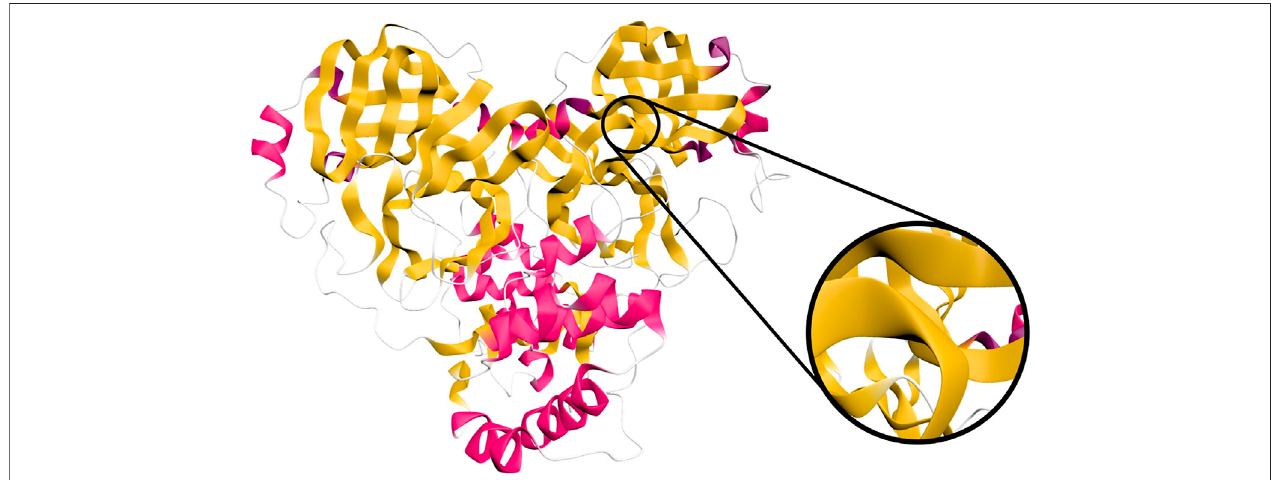
FIGURE 4 | Ribbon diagram of the SARS-CoV-2 main protease (PDB ID 6W63), as rendered in Narupa iMD using the cartoon representation. Shown inset is a close-up of a beta strand which exhibits a turn close to 90 ° , highlighting its similarity to a twist when viewed from a distance. An animation of this is provided in Supplementary Video S4 of the supplementary